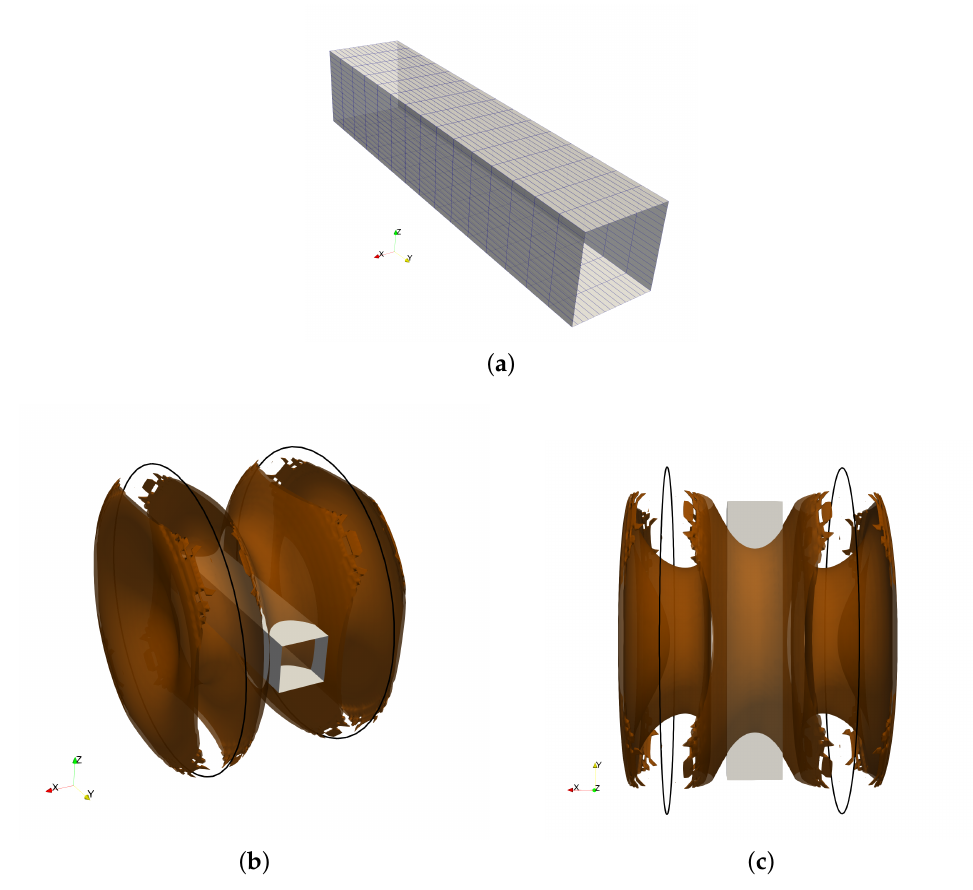
Figure 5. Shield used in the identification procedure ( a ). Shield immersed in the magnetic field created by the Helmholtz coils. The surface represents the homogeneity volume considering 5% of tolerance ( b , c